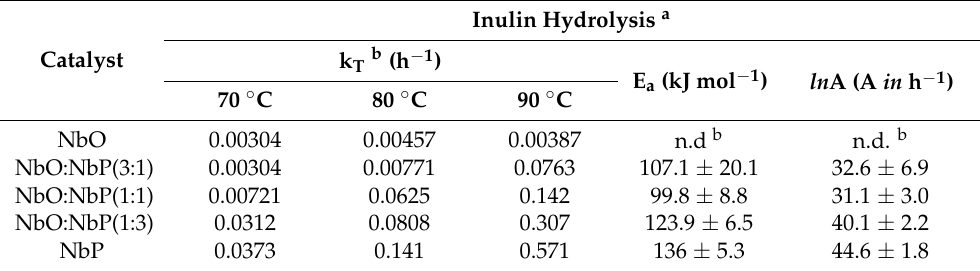
Table 2. Kinetic and activation parameters for the reaction catalytic hydrolysis of inulin.